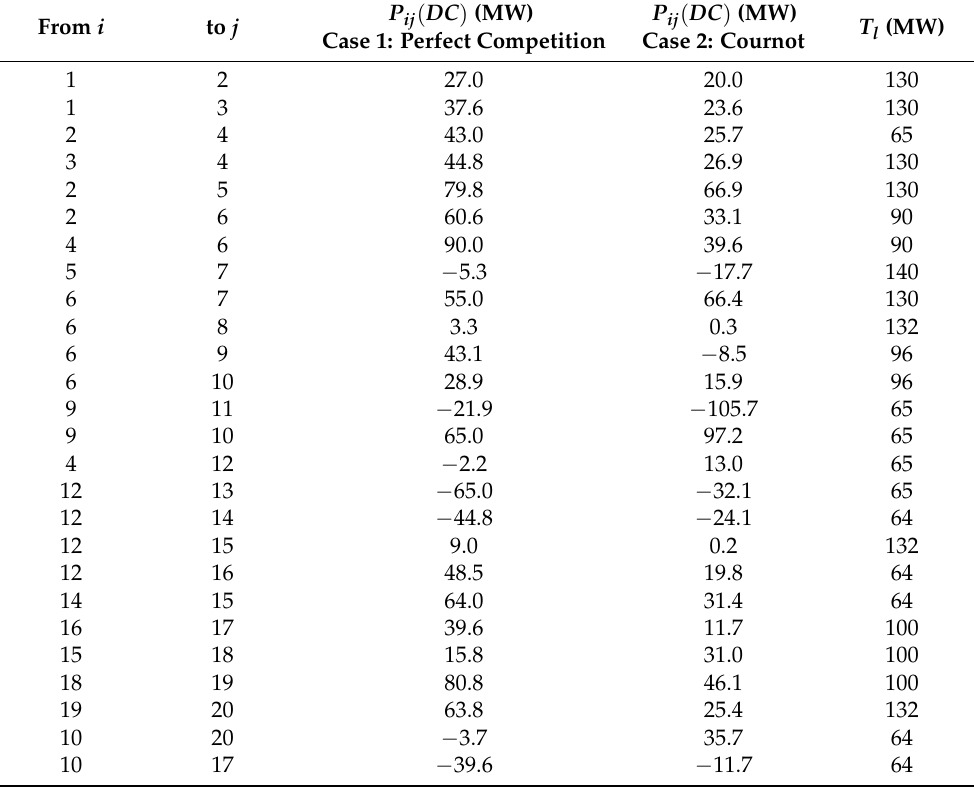
Table 8. DC load flow for PC and